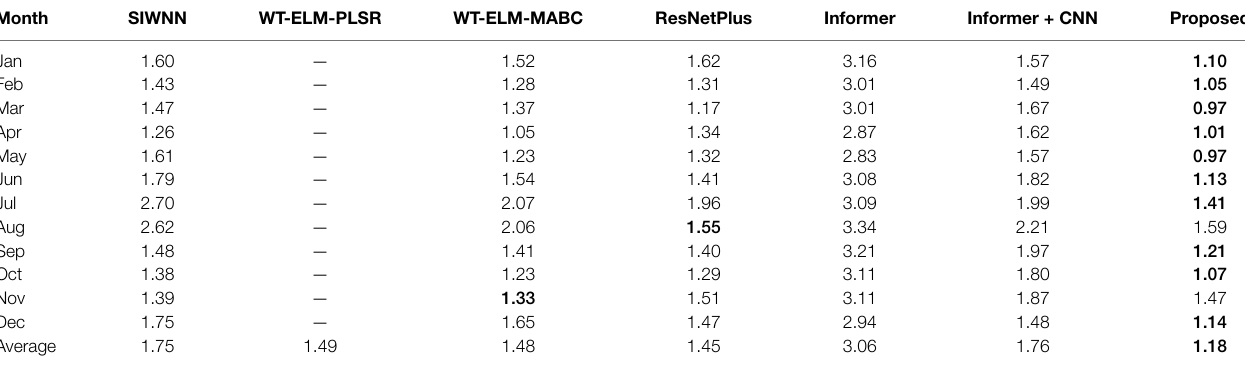
The bold values are the best results as compared to the others.